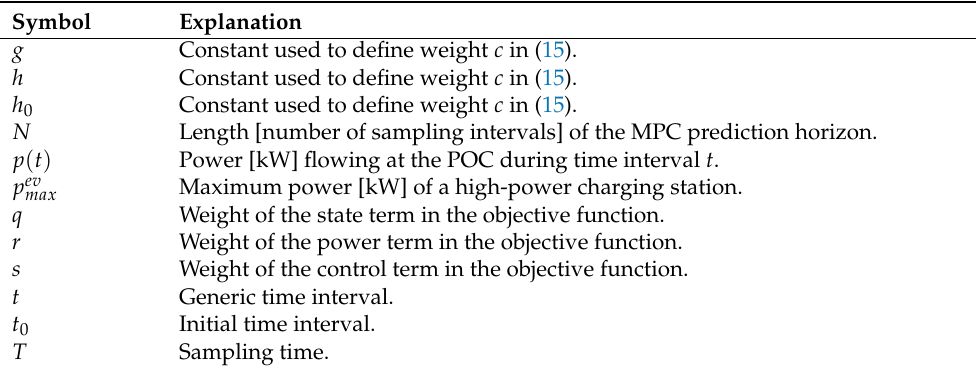
Table 1. Nomenclature used in the